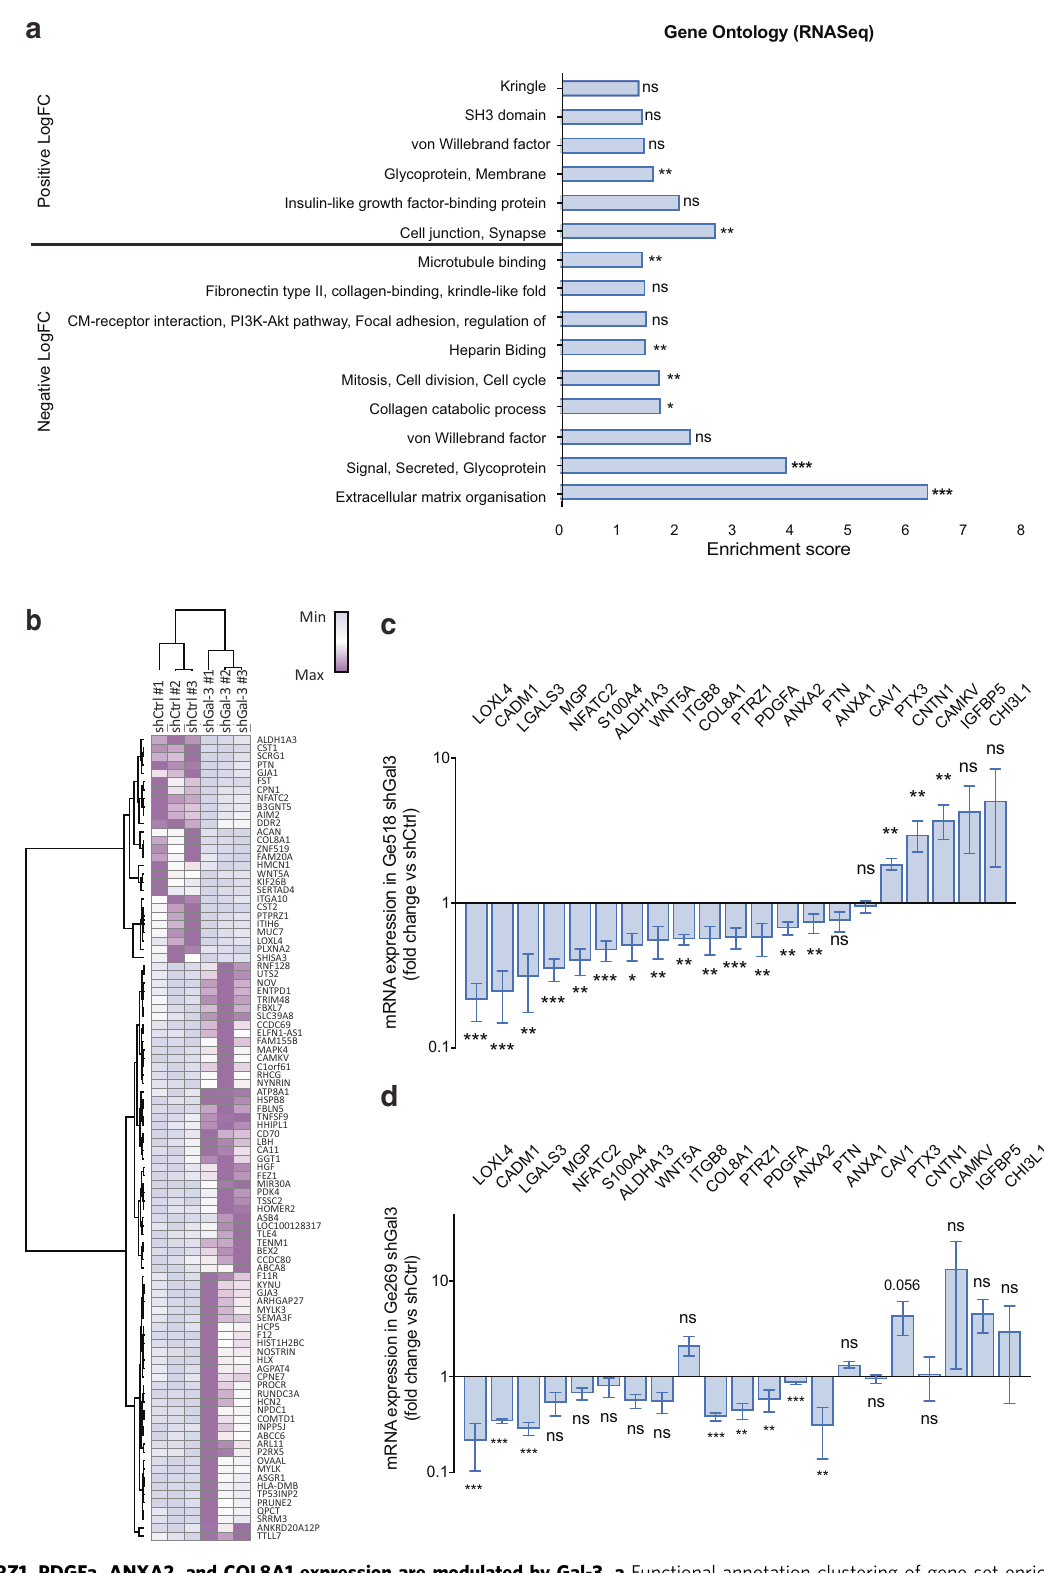
Fig. 4 PTPRZ1, PDGFa, ANXA2, and COL8A1 expression are modulated by Gal-3. a Functional annotation clustering of gene set enrichment analysis comparing Ge518 shCtrl vs. shGal-3. Histograms show the enrichment score of each family of genes. b Hierarchical clustering of Ge518 shCtrl vs. shGal-3 based on the differential expressed genes. c mRNA expression was determined by qPCR in Ge518 infected by shRNA Control (shCtrl) vs. shGal-3 ( n = 2 – 3). d mRNA expression was determined by qPCR in Ge269 infected by shCtrl vs. shGal-3 ( n = 2 – 3). Data are represented as mean ± SEM (* p < 0.05, ** p < 0.01, and *** p < 0.001), Student t test. ns nonsigni fi